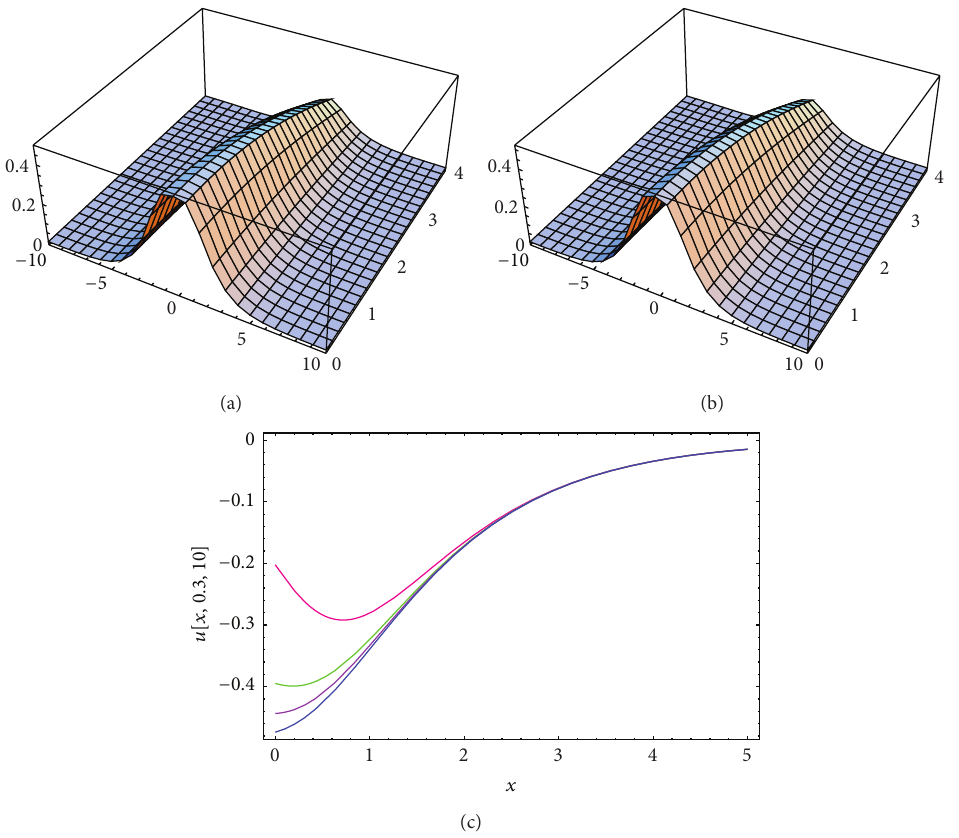
Figure 1: (a) and (b) The surface shows the solution 𝑢(𝑥,𝑦, 𝑡) for (8): (a) approximate solution for 𝛼 = 1.98, ℎ = −1.1 ; (b) exact solution. (c) Four profiles of approximate solutions 𝑢(𝑥,𝑦,𝑡) for some values of 𝛼 : blue line ( 𝛼 = 2 ), mauve line ( 𝛼 = 1.9 ), green line ( 𝛼 = 1.8 ), and red line ( 𝛼 = 1.5 ), when 𝑘 1 = 0.1, 𝑘 2 = 0.03, 𝑘 3 = −0.3, 𝜎 = 𝐼 , and 𝜆 = 1